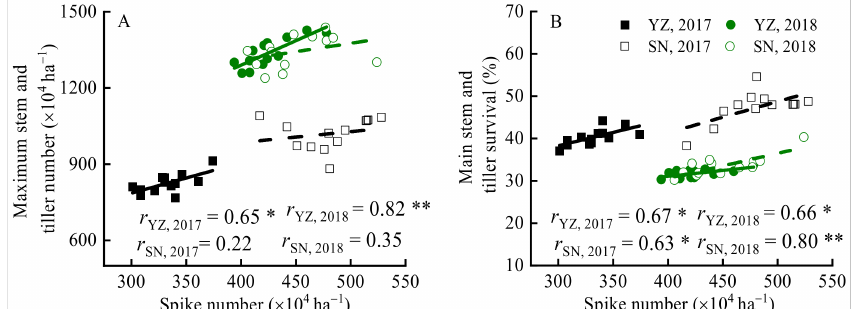
Figure 2. Correlations between spike number and ( A ) maximum stem and tiller number and ( B ) main stem and tiller survival of different cultivars in southern (YZ, Yangzhou) and northern (SN, Suining) areas of the Yangtze River basin, China, in 2017 and 2018. * p < 0.05; ** p < 0.01; ns, nonsignificant.